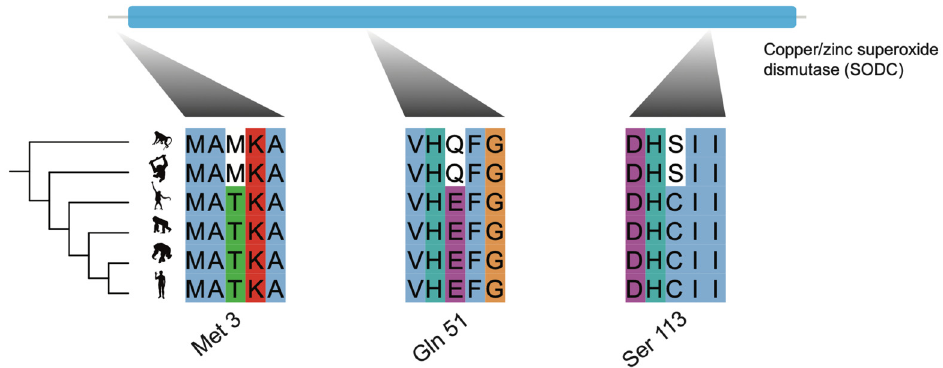
Figure 2. Positive selection targeting on SOD1 in the common ancestor of great apes. The top blue bar denotes the functional domain of SOD1 . SOD1 experienced positive selection at multiple sites (Met 3, Gln 51, Ser 113). Animal illustrations are from phylopic.org, and are credited to NASA ( H. sapiens